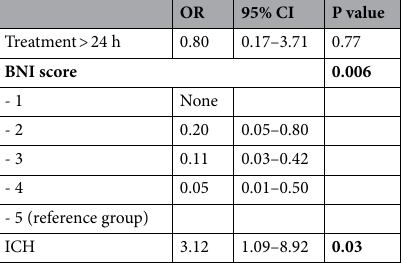
Table 3. Multivariable analysis rebleeding. BNI Barrow Neurological Institute, ICH intracerebral haemorrhage. Significant values are in bold.